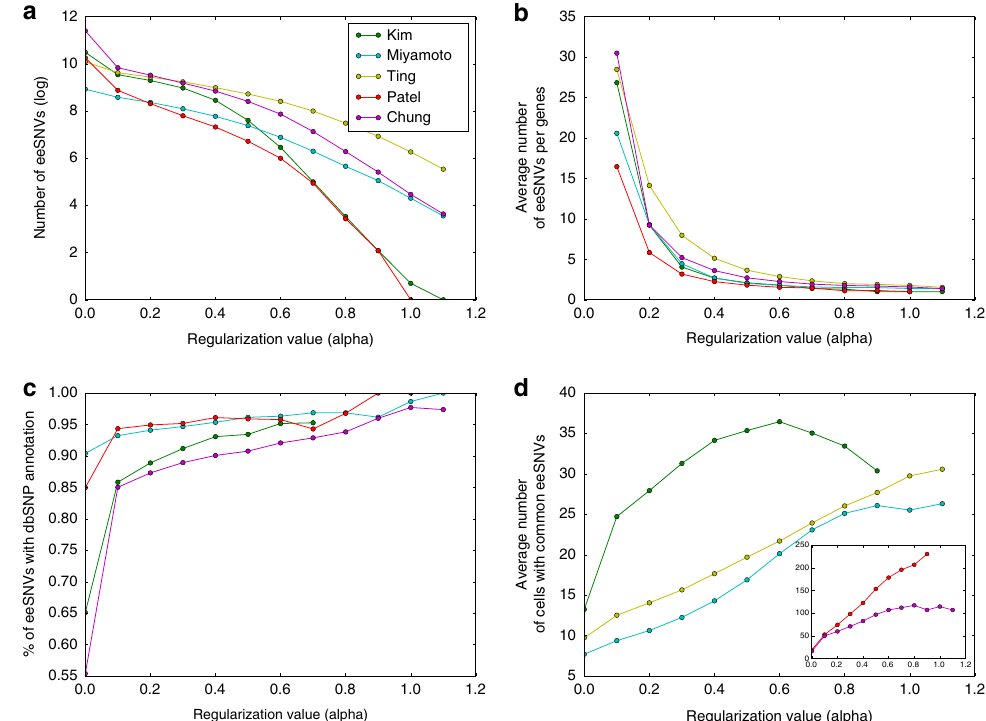
Fig. 4 Characteristics of the eeSNVs. X -axis: the regularization parameter a values used by LASSO penalization in the SSrGE models. And the Y -axes are: a Log10 transformation of the number of eeSNVs. b The average number of eeSNVs per gene. c The proportion of SNVs with dbSNP138 annotations (human datasets). d The average number of cells sharing eeSNVs